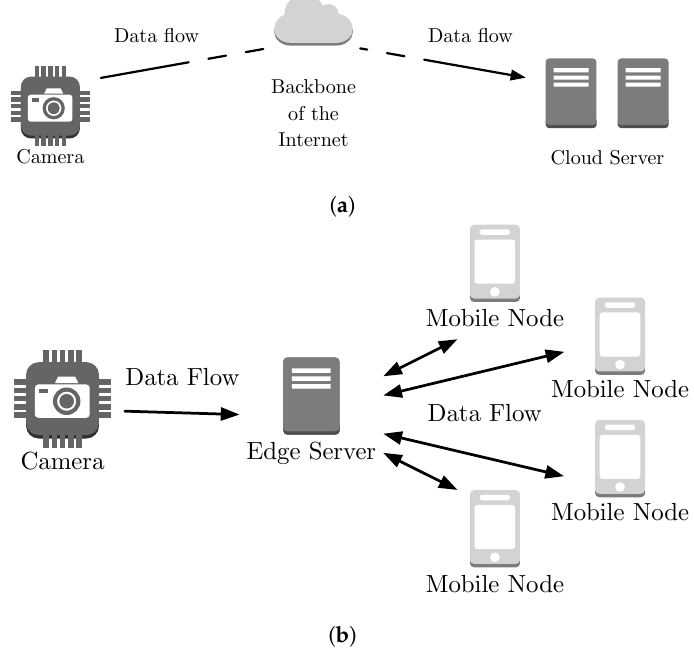
Figure 6. Architectures for experimentation: ( a ) Cloud Architecture and ( b ) SLedge Edge Architecture.